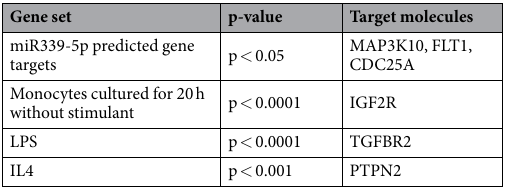
Table 3. Association between the STAT3 pathway and respective gene sets (miR339-5p predicted gene targets, or genes differentially expressed between high and low collateral capacity patients in monocytes cultured with no stimulant, or stimulation with LPS or IL4). The listed target molecules are molecules that are linked to each respective gene-set and are associated with the STAT3 pathway. High-lighted molecules share a common parent node in the STAT3 pathway; the common parent node being growth factor receptor (GF receptor).CDC25A, Cell division cycle 25 homolog A; FLT1, FMS related tyrosine kinase 1; IGF2R, Insulin-like growth factor 2 receptor; TGFBR2, Transforming growth factor beta receptor